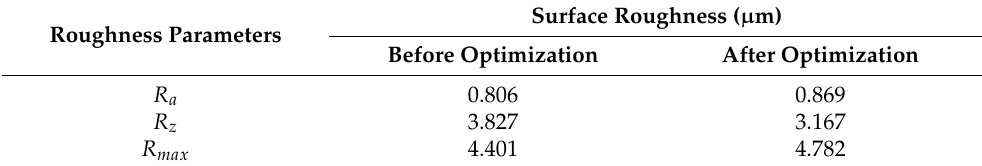
Table 5. The measurement results of surface roughness.